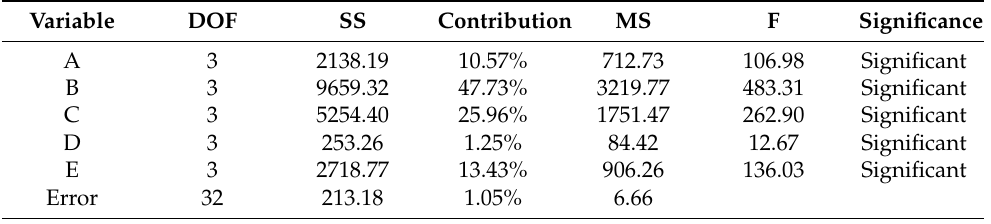
Table 8. Analysis of Variance Result.